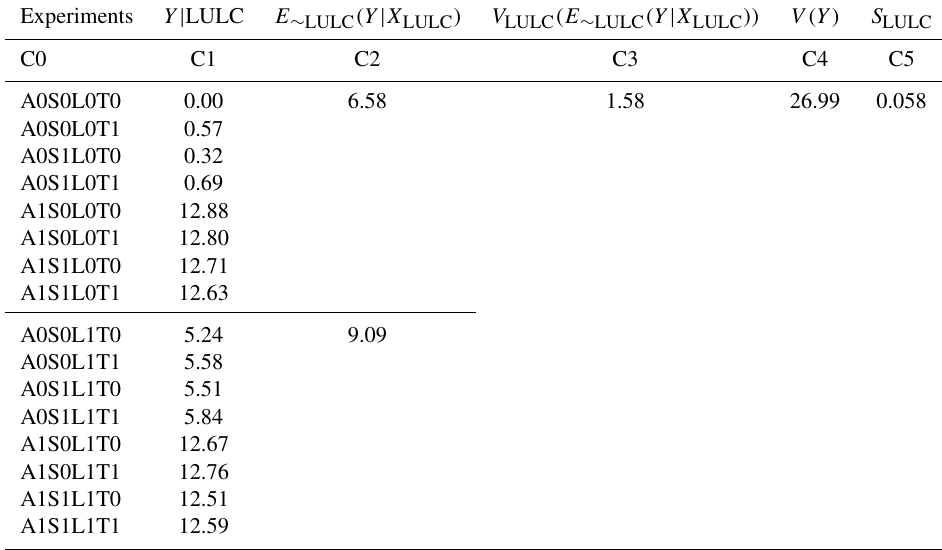
Table A2. Calculation of Sobol’ first-order sensitivity index.